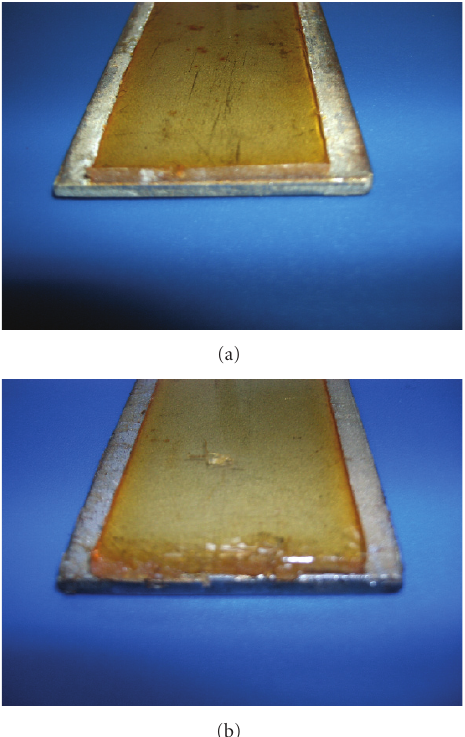
Figure 18: Comparison before and after the action (a) without action, (b) with